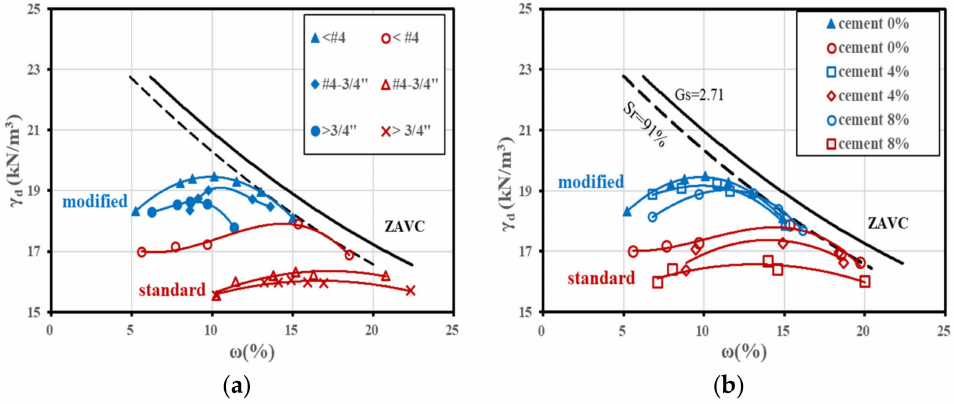
Figure 6. Compaction curves and zero air void curves (ZAVC) from the compaction tests for various mix conditions: ( a ) mudstone; ( b )